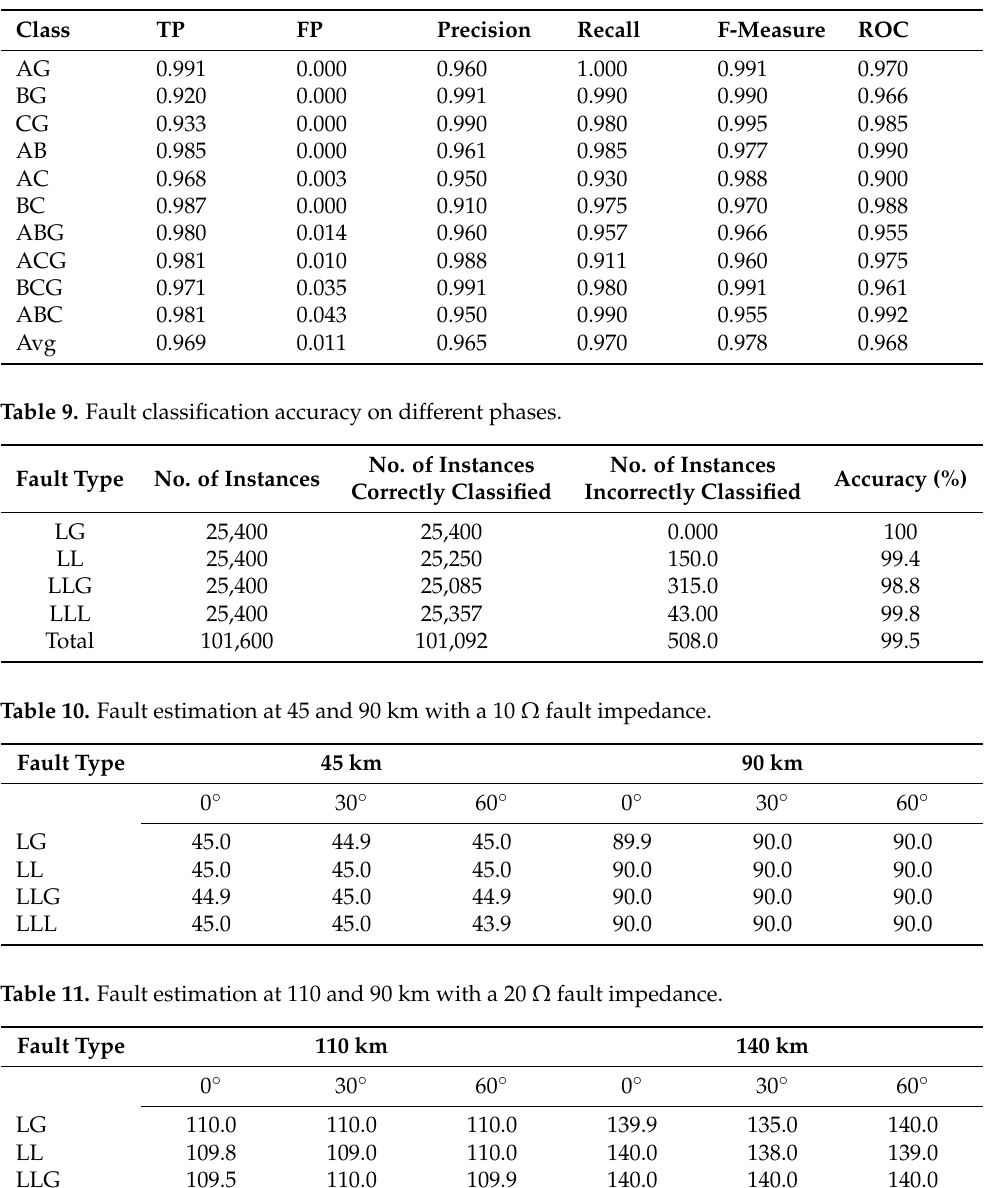
Table 8. SVM classification with two cycles post-fault.